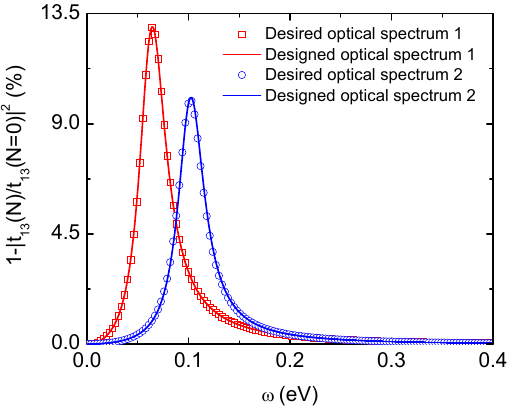
Figure 4. (Color online) Two examples of the inverse design using the tandem neural network. The solid curves and data points correspond to the predicted spectrum and target/desired spectrum,